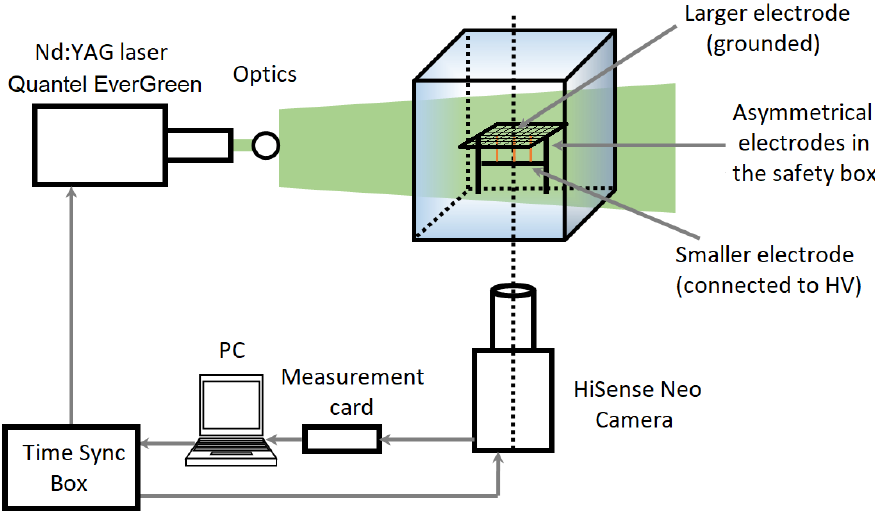
Figure 2. Schematic diagram of measuring PIV setup.